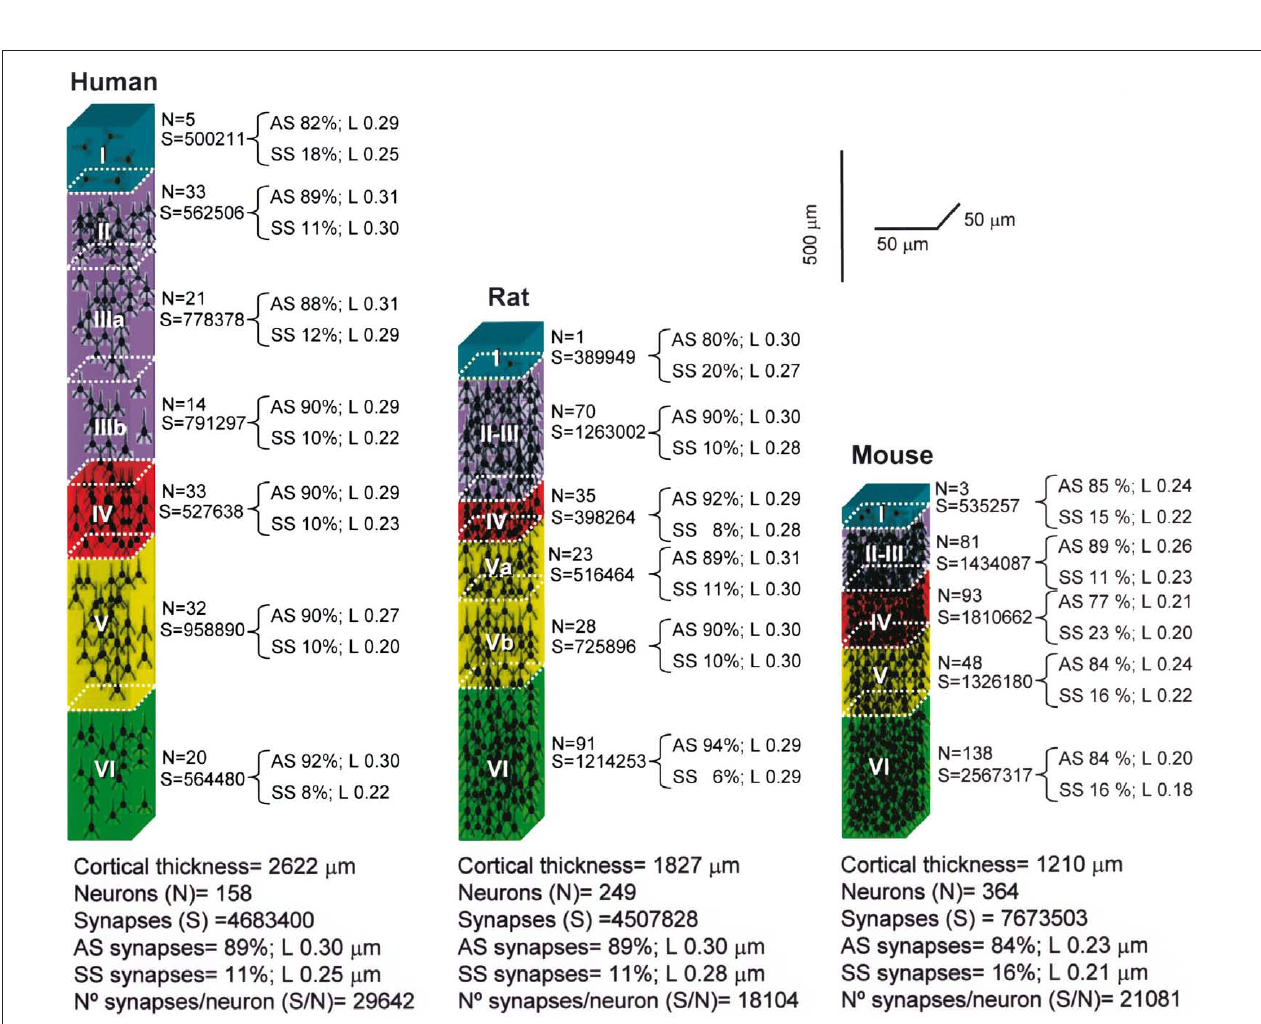
Figure 12 | electron microscopy and number of synapses per neuron. Left, Electron micrographs illustrating the neuropil of layer IIIa in the human temporal cortex, and of layer III of the mouse barrel cortex. Note the higher density of synapses (some of them indicated by arrows) in the mouse cortex. Scale